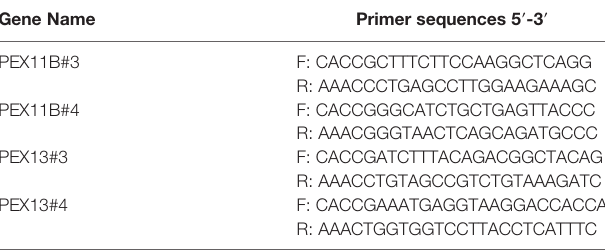
TABLE 1 | The oligonucleotide sequences of PEX11B and PEX13 single guide (sg)